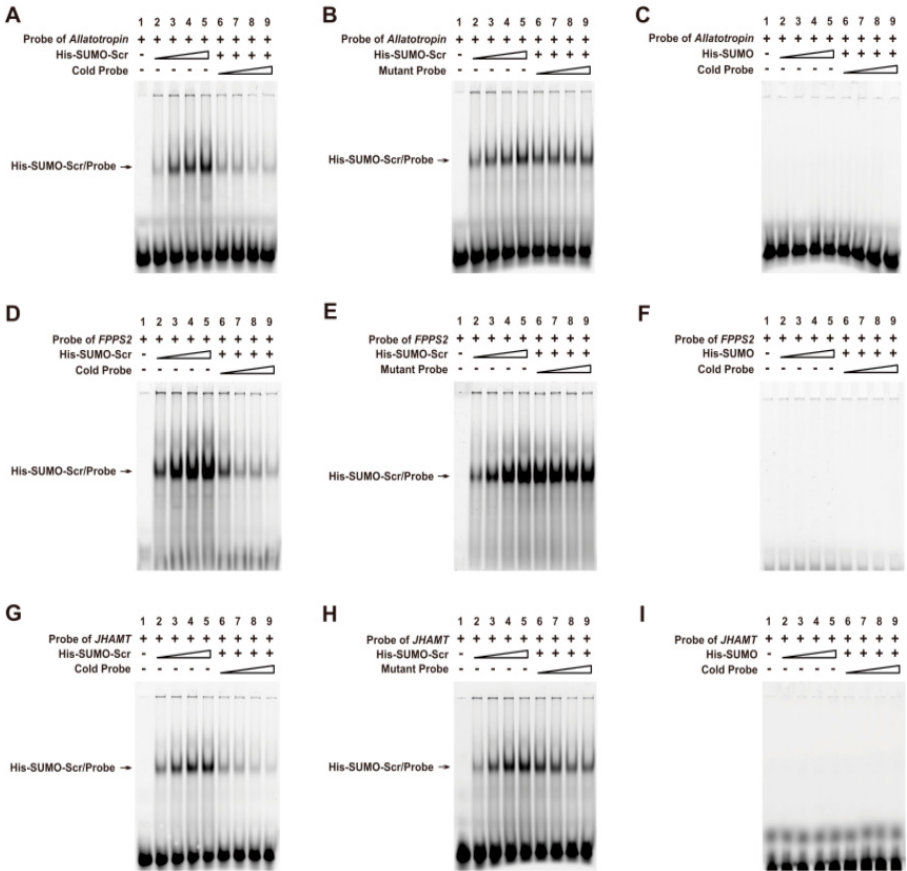
Figure 9. Direct binding of the Scr protein to the CREs in the promoters of genes involved in JH biosynthesis. ( A , D , G ) A series of EMSAs indicated that recombinant His-SUMO-Scr bound in a dose-dependent manner to the labeled probes in the promoters of Allatotropin , FPPS2 , and JHAMT , and the binding could be competitively suppressed by the respective unlabeled probe; ( B , E , H ) The unlabeled mutant probes could not suppress the binding of the recombinant His-UMO-Scr to the labeled probes; ( C , F , I ) The His-SUMO tag alone could not bind to the labeled probes. The stepped shapes mean the increasing does of the recombinant proteins, the cold probes or the mutant probes respectively.